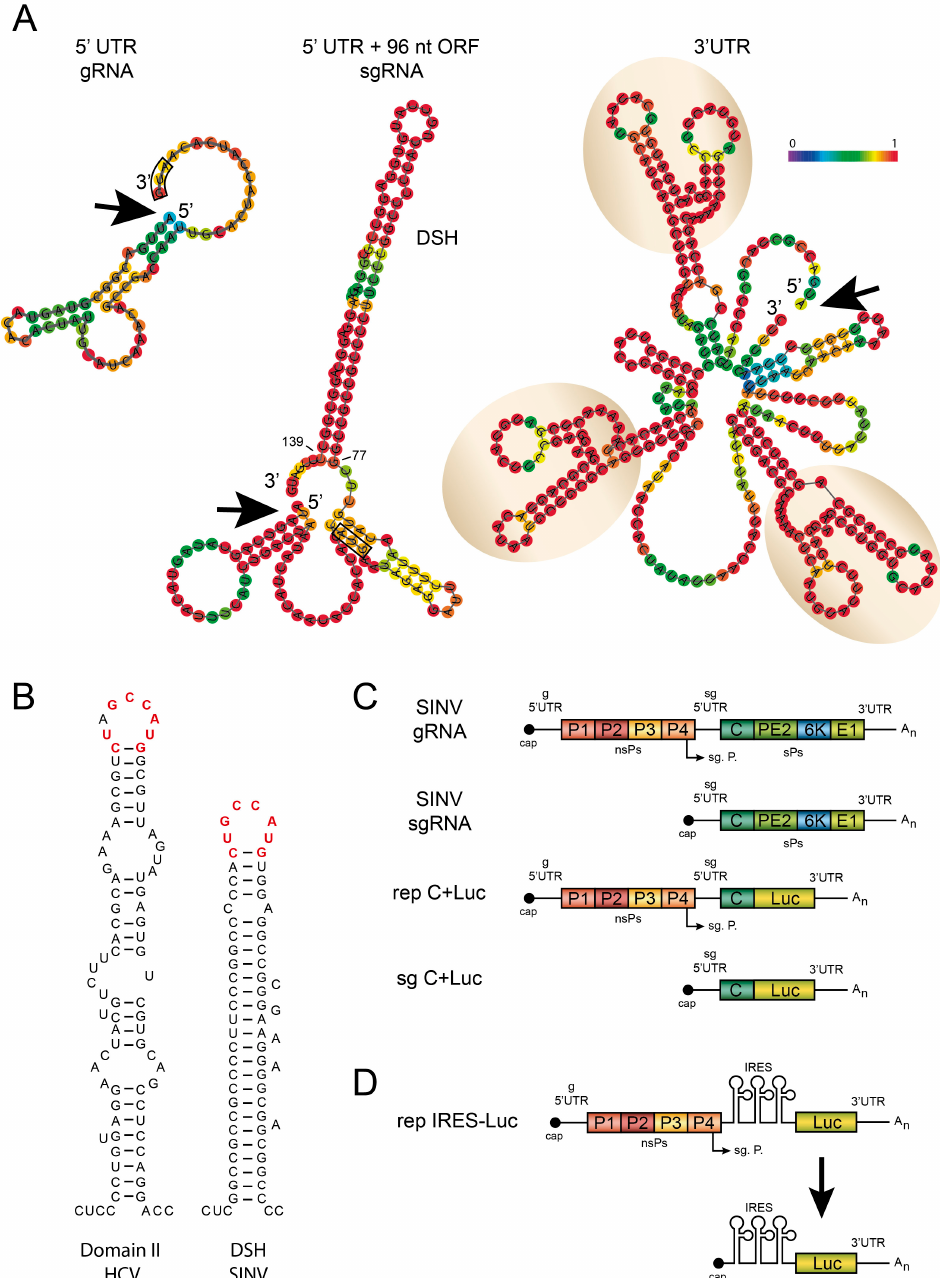
Figure 3. Some structural features of SINV mRNAs. ( A ) Secondary structure of the 5 ′ -UTR and 3 ′ -UTR regions of SINV gRNA and sgRNA. The 5 ′ -UTR + 96 nt ORF of sgRNA include the downstream stable hairpin (DSH) from 77 to 139 nt. 5 ′ -UTR gRNA has a free energy of the thermodynamic ensemble is − 7.77 kcal/mol. 5 ′ -UTR + 96 nt ORF sgRNA has a free energy of the thermodynamic ensemble is − 60.31 kcal/mol. 3 ′ -UTR has a free energy of the thermodynamic ensemble is − 90.54 kcal/mol. These structures were obtained by The Vienna RNA Website. Nucleic Acids Res. 2008 (website tool: http://rna.tbi.univie.ac.at/cgi-bin/RNAWebSuite/RNAfold.cgi) and are colored by base-pairing probability. AUG start codons are shown surrounded by black boxes. Black arrows indicate the 5 ′ end of each RNA secondary structure. The three stem-loops at the 3 ′ -UTR structure are highlighted within circles; ( B ) secondary structure of HCV Domain II and SINV DSH where similarity of the loops is marked in red; ( C ) schematic representation of SINV gRNA, sgRNA and the constructions encoding luciferase: (replicon) rep C+Luc and sgRNA C+Luc; ( D ) schematic representation of SINV construct containing the leader sequence of sgRNA replaced by an IRES element followed by the luciferase gene and the sgRNA synthesized from it. IRES: internal ribosome entry